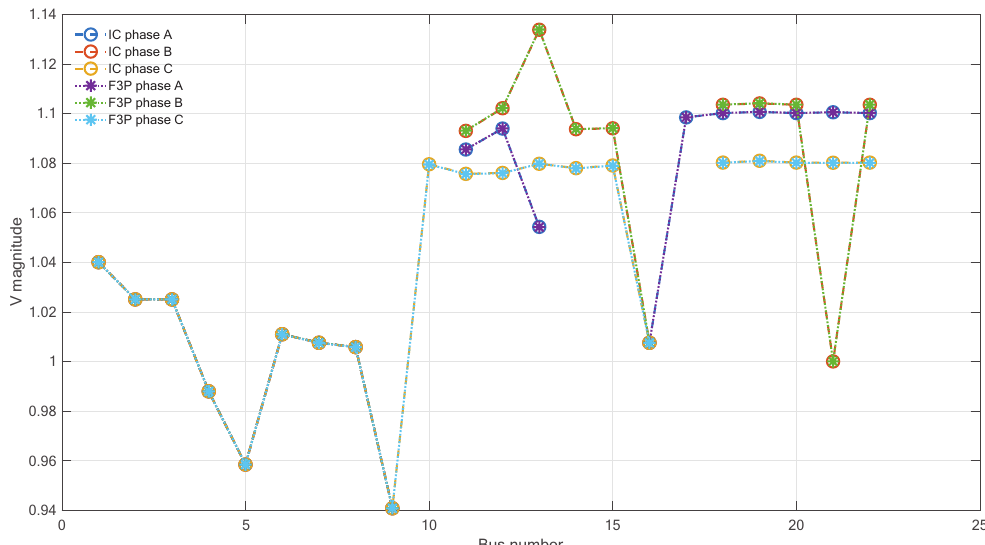
Figure 5. Per-unit voltage profile of the three phases of the Interconnected and full three-phase method. The represented network is the T9-D13 network.